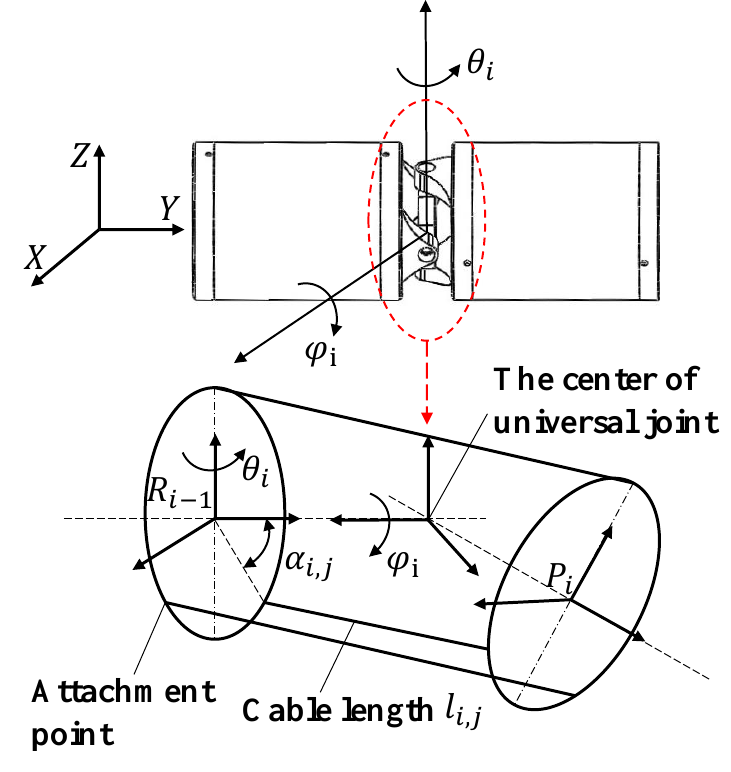
Figure 4. A geometric model of universal joint. Table 1. The properties and values of some